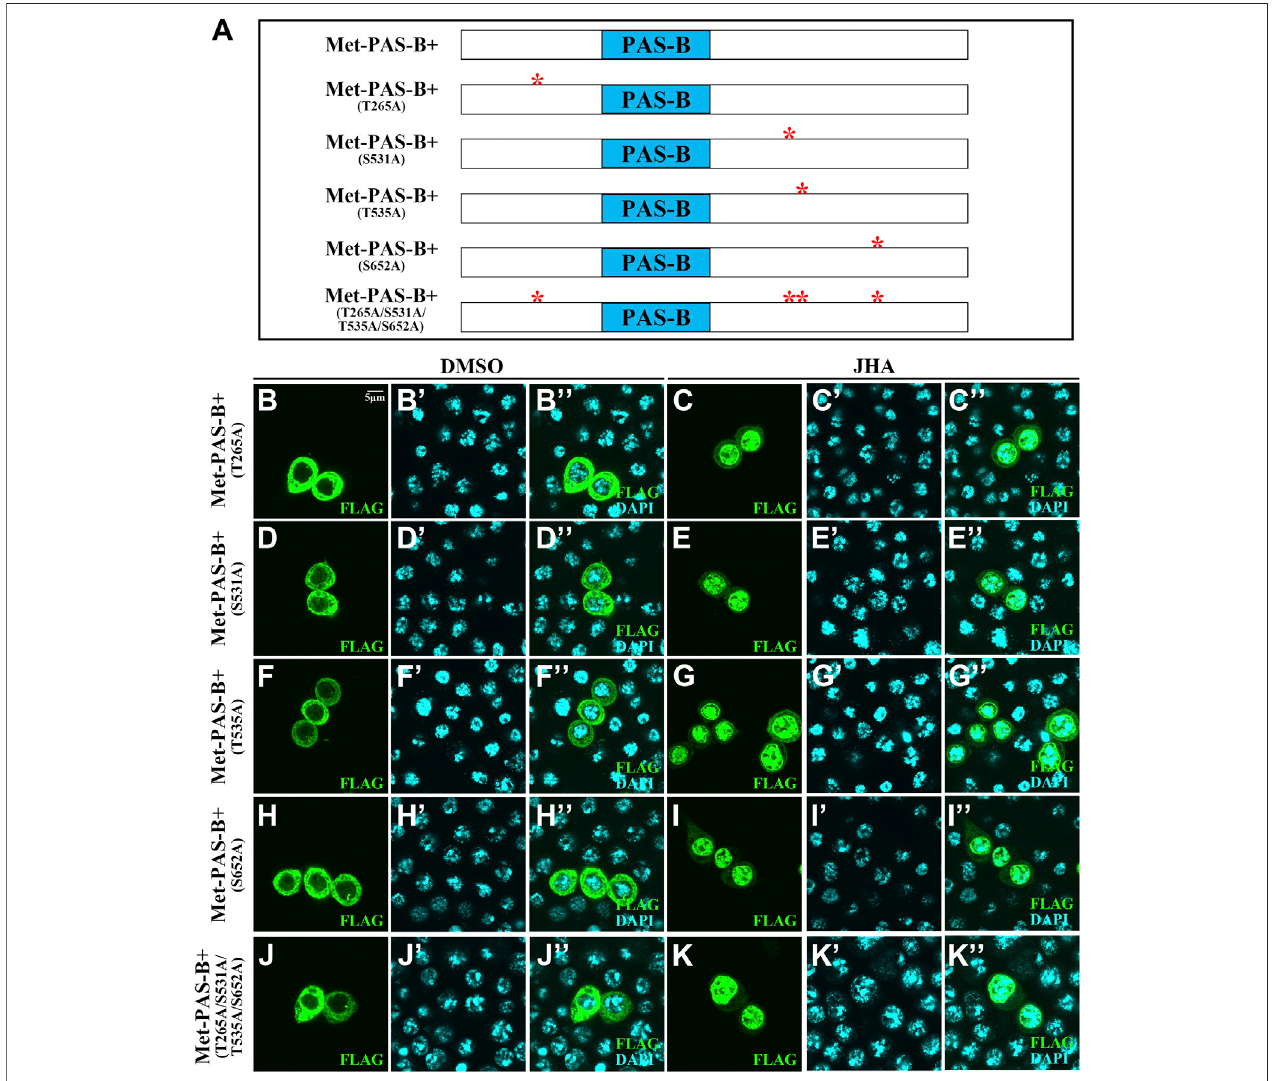
FIGURE4| Localization ofmutationsofphosphorylationsite mutants inthe PAS-B+ region when Kccells weretreated withDMSO or JHA. (A) Scheme illustrating Met-PAS-B+ fragment and mutations of phosphorylation sites in PAS-B+ of Met. (B – K ’’ ) Localization of mutations of phosphorylation sites in PAS-B+ of Met was all altered in the presence of JHA compared to the control DMSO treatment. Cells expressing mutations of phosphorylation sites in PAS-B+ of Met were stained for FLAG (green) and DAPI (blue).